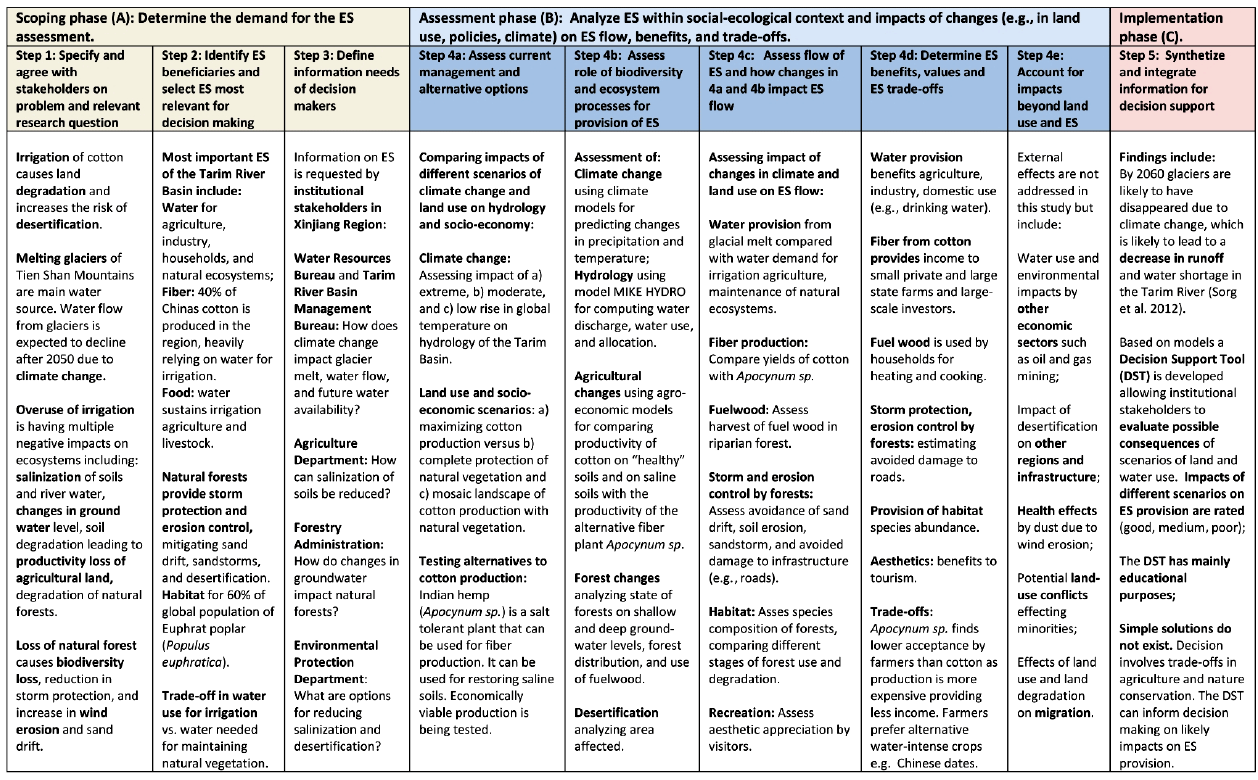
Fig. 6 . Problem-oriented approach for assessing ecosystem services (ES): the case of the SuMaRiO project in the Tarim River Basin in China (Rumbaur et al.